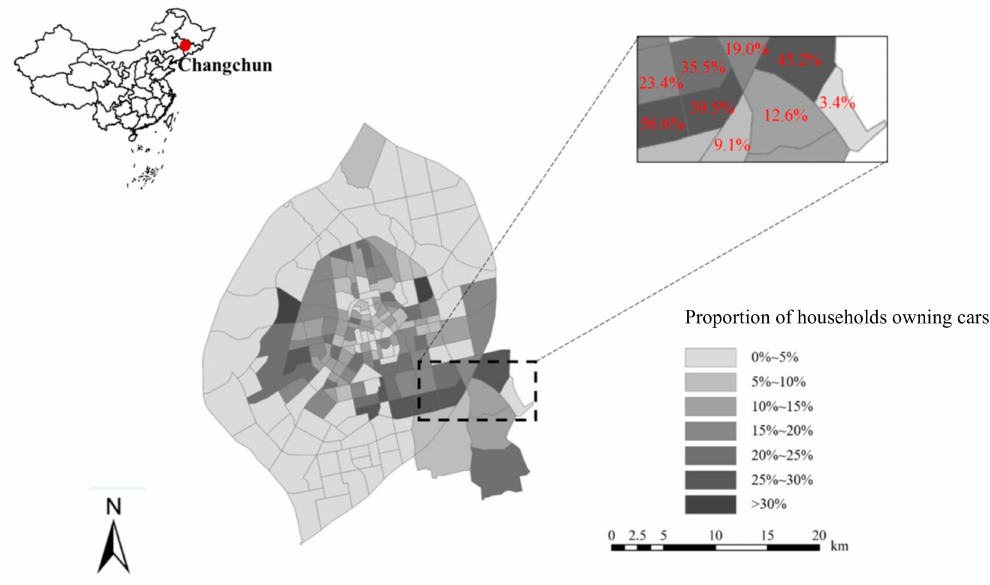
Figure 1. Study region and traffic analysis